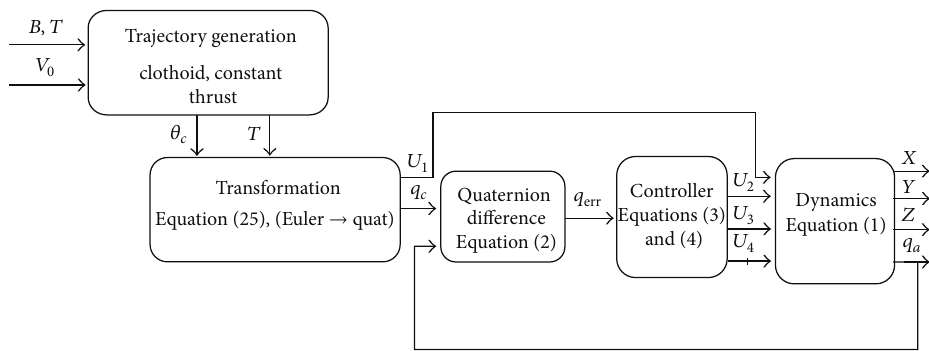
Figure 9: System block diagram.